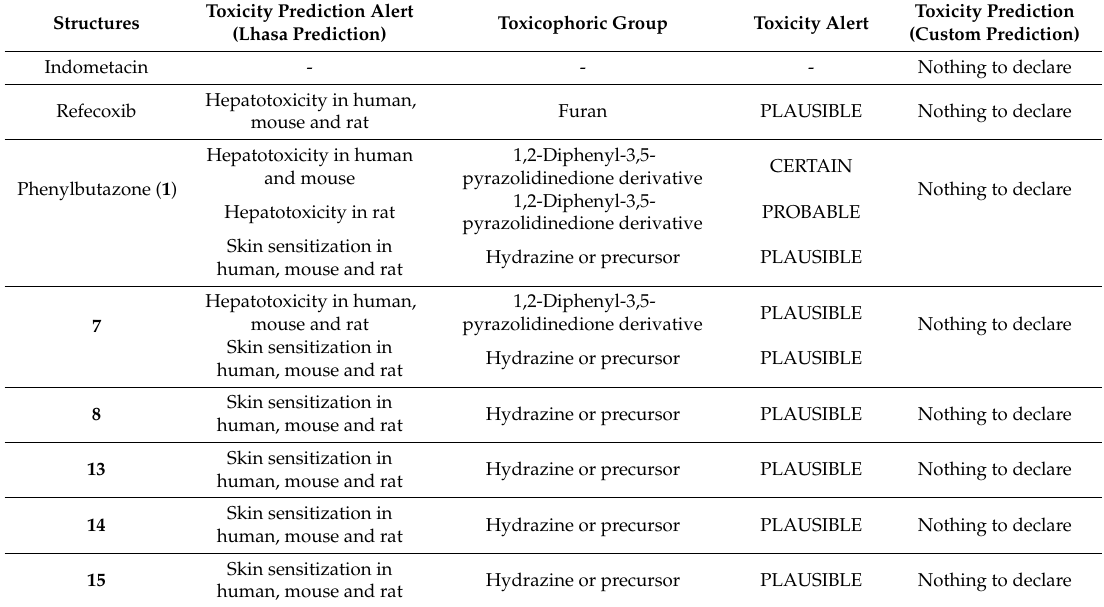
Table 3. Predictions of the toxicological properties of structures